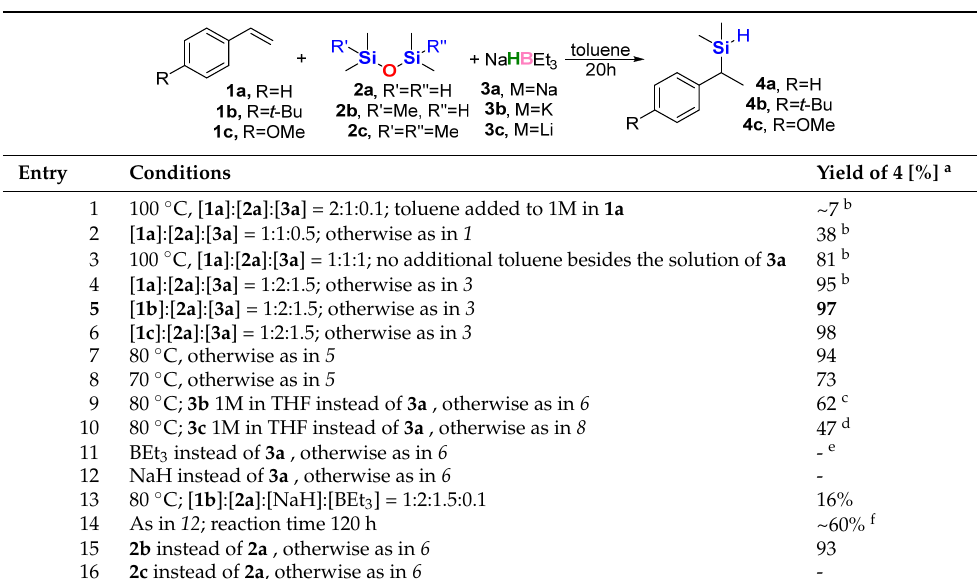
Table 1. Summary of the experiments performed to establish the reaction conditions and the initial mechanistic investigation.